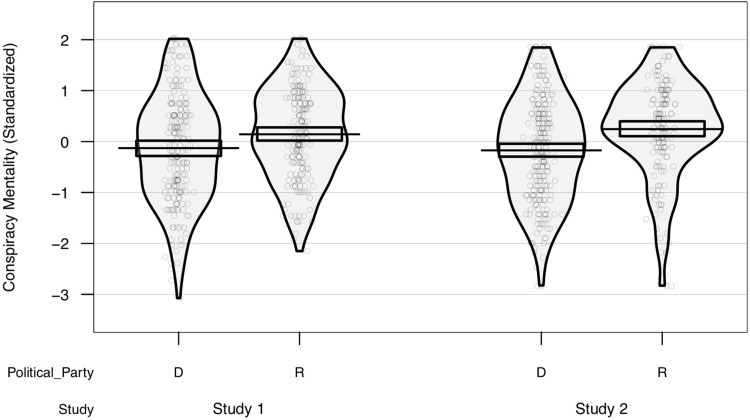
Conspiracism and political party.Conspiracy mentality as a function of political party affiliation. Scatterplot points are individual scores, jittered along the (meaningless) horizontal axis to reduce overlap. Only data from self-identified Democrats (D) and Republicans (R) included. Beans show smoothed density of data points. Bars and boxes represent means and Bayesian 95% highest density intervals, respectively.